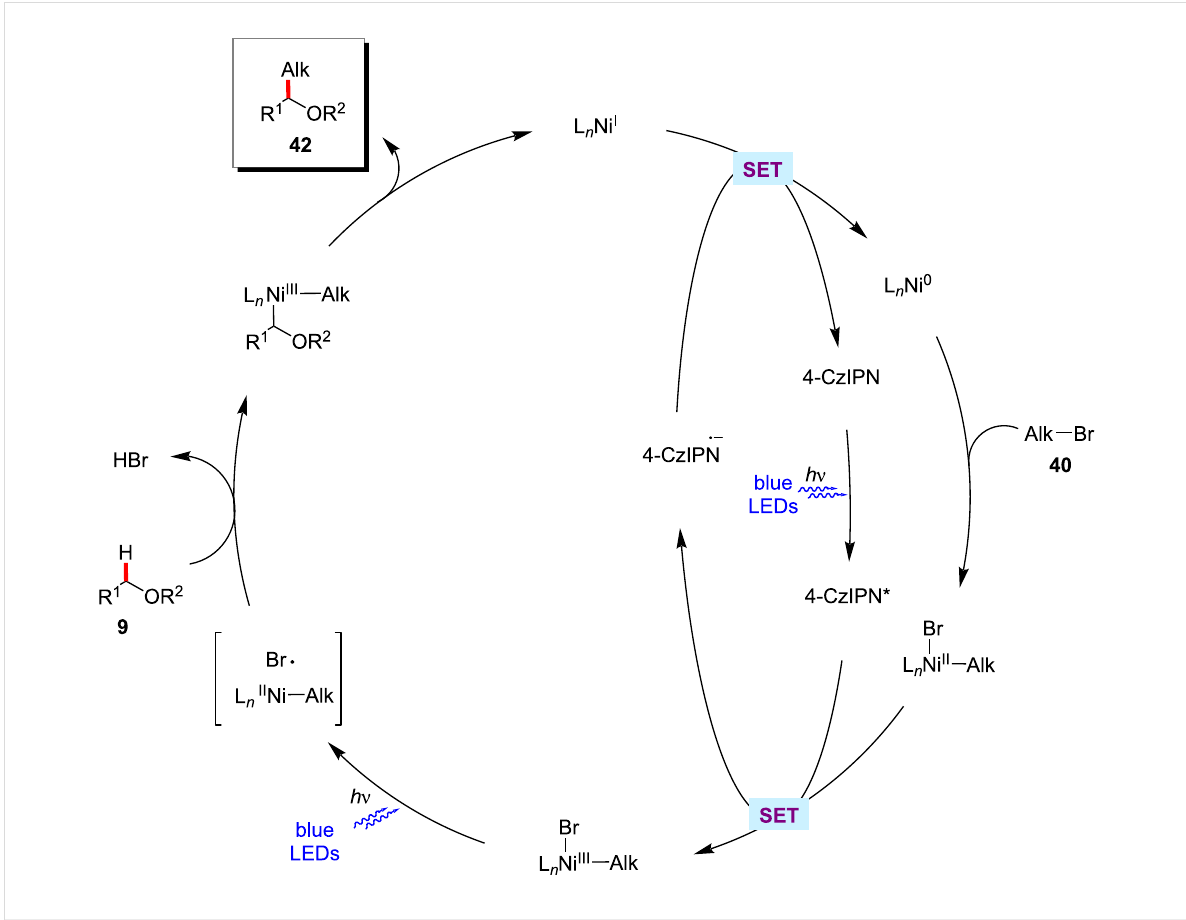
Figure 13: Proposed mechanism for the CzIPN and nickel-catalyzed C(sp 3 ) ‒ H alkylation of ethers.